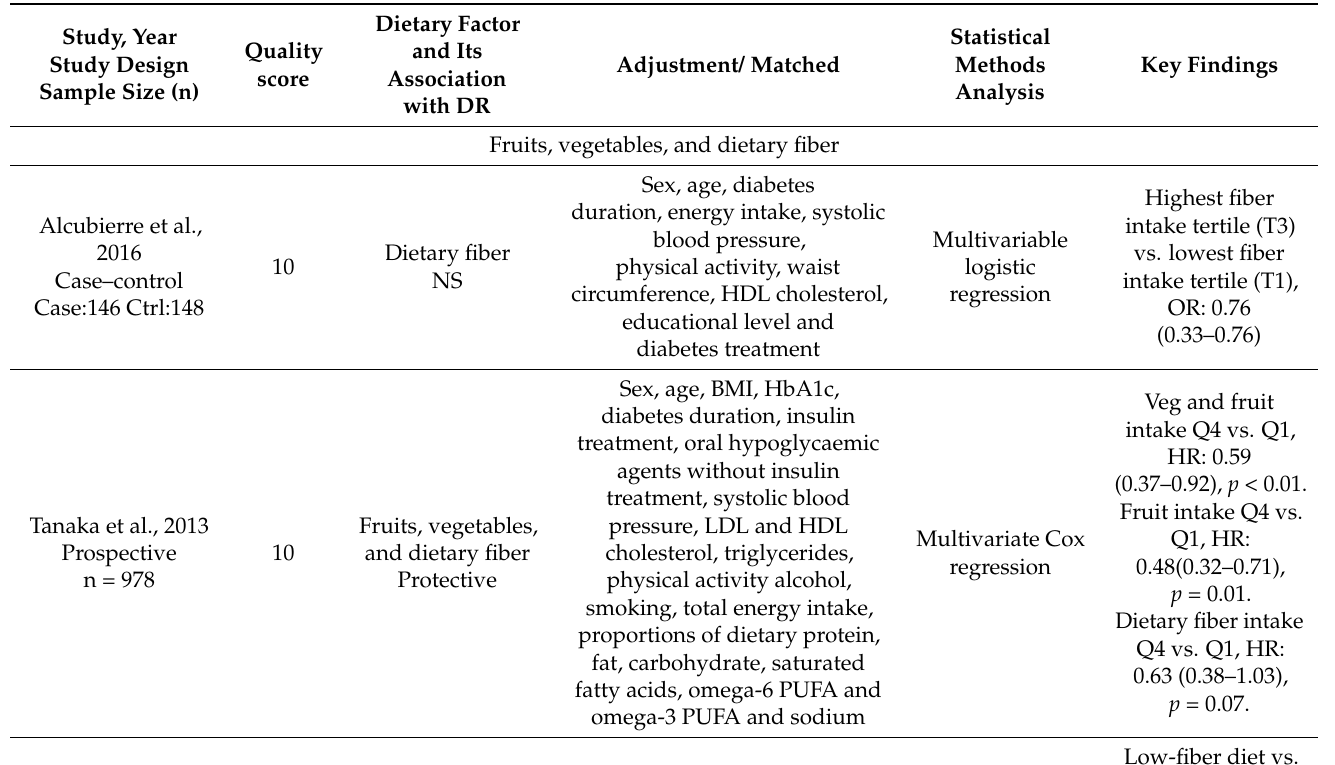
Table 4. Dietary intake of foods and diabetic